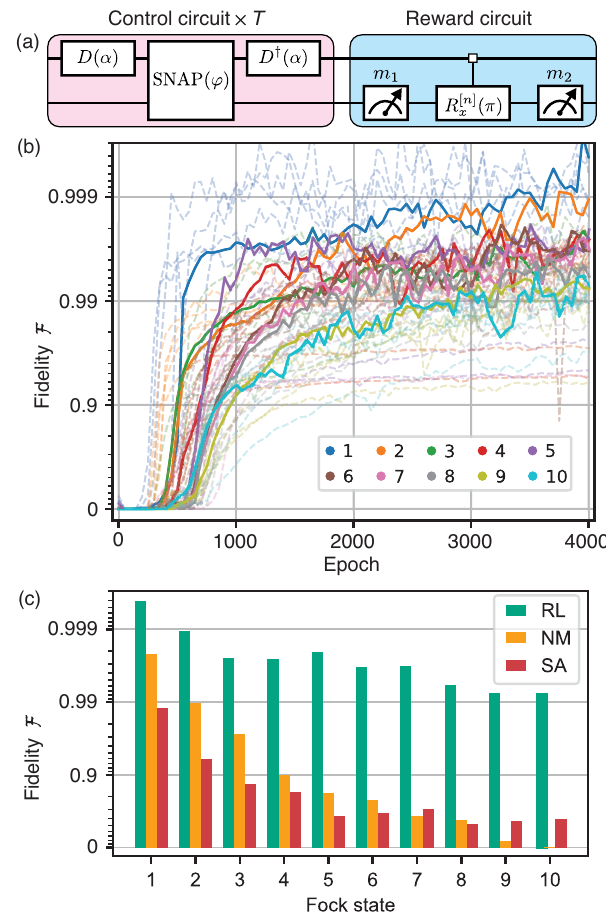
FIG. 2. Preparation of Fock states j 1 i ; … ; j 10 i . (a) Parametrized control circuit (pink) and Fock reward circuit (blue). The reward circuit contains a selective π pulse on the qubit, conditioned on having n photons in the oscillator. (b) Evaluation of the training progress. The background trajectories correspond to six random seeds for each state; solid lines show the trajectory with the highest final fidelity. (c) Summary of comparison of different model-free approaches on the task of Fock state preparation. We perform extensive hyperparameter tuning for all three ap- proaches, as described in Sec. IVA for RL, and in Appendix B for Nelder-Mead (NM) and simulated annealing (SA). All approaches are constrained to the same total sample size of 4 × 10 6 . The displayed final fidelity is the highest M tot ¼ achieved among six tested random